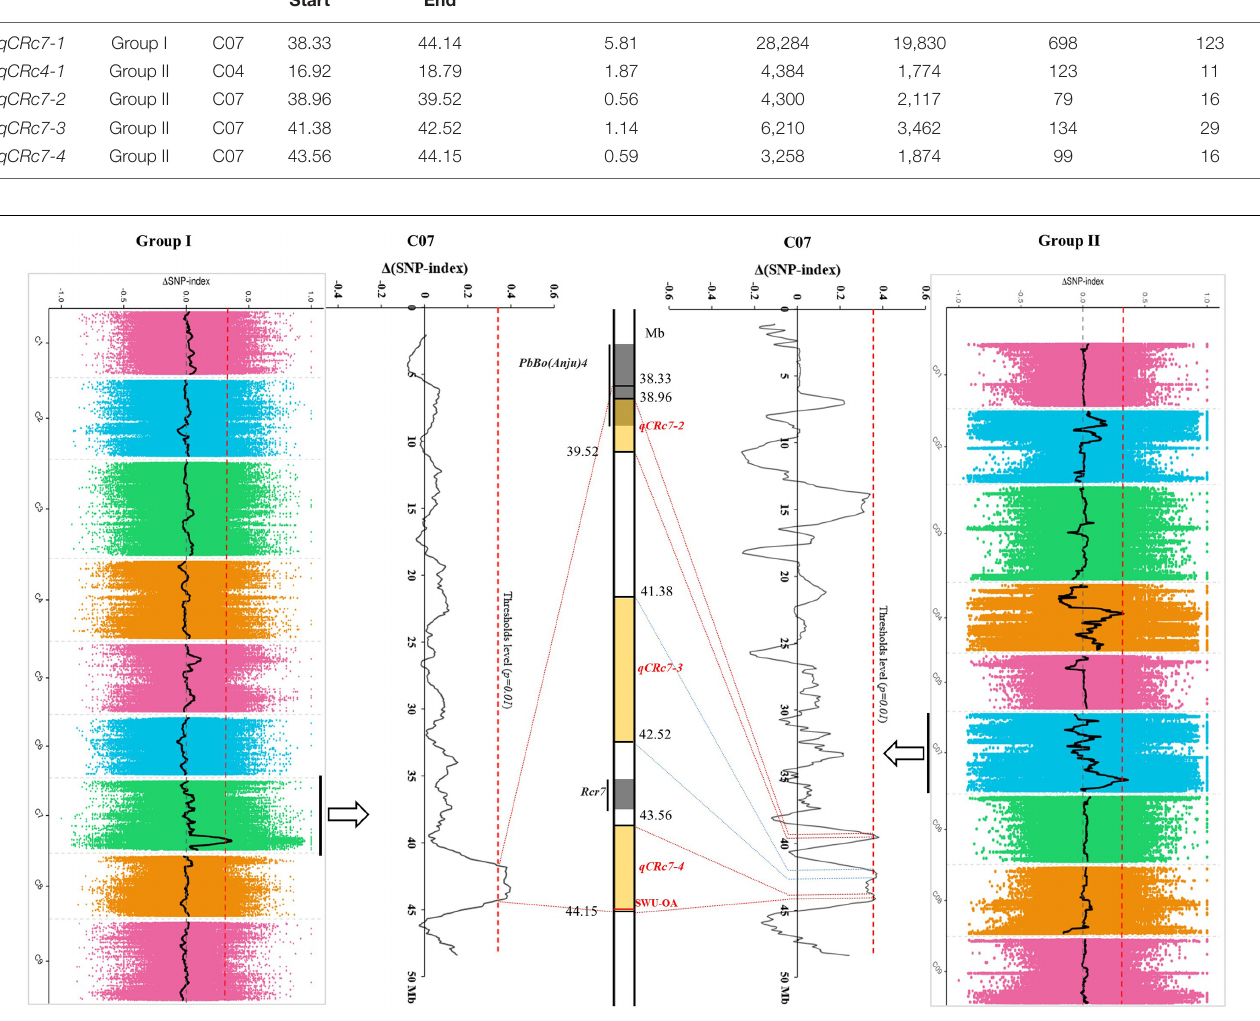
FIGURE 2 | Comparison of clubroot resistance (CR)-quantitative trait loci (QTLs) identified by QTL-sequencing (QTL-seq) from group I (left) and group II (right) . The physical map of chromosome C07 (partial) was presented in the middle, with yellow backgrounds indicating QTLs identified in this study and gray backgrounds indicating loci identified in other